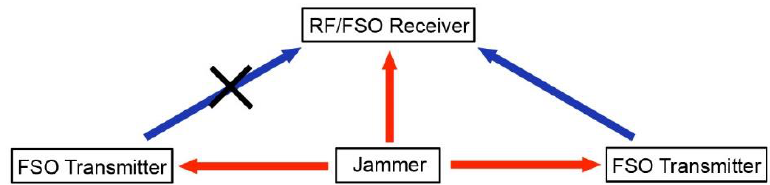
Figure 8. Switch from a blocked FSO channel to an unblocked FSO channel.